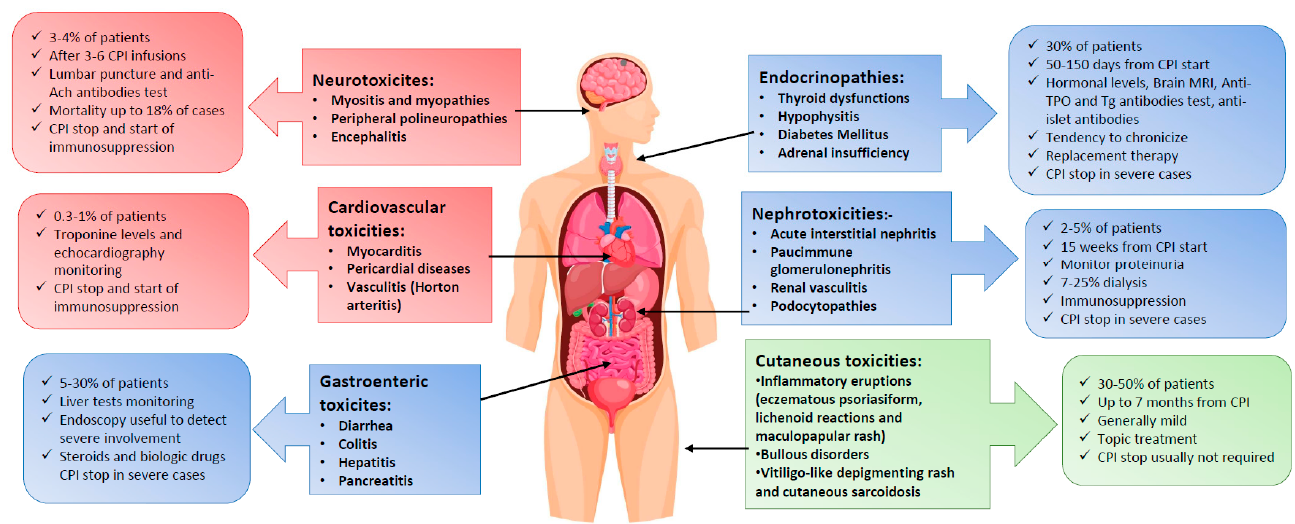
Figure 2. Extra-hematologic immune-related adverse events (IRAEs) after checkpoint inhibitors